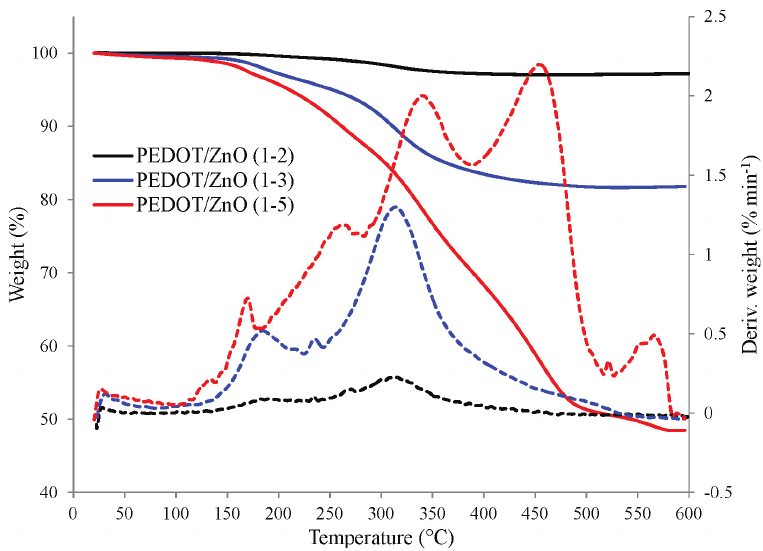
Fig. 4 – TG curves of PEDOT/ZnO samples synthesized by various monomer to APS oxidant ratio (1:2, 1:3,